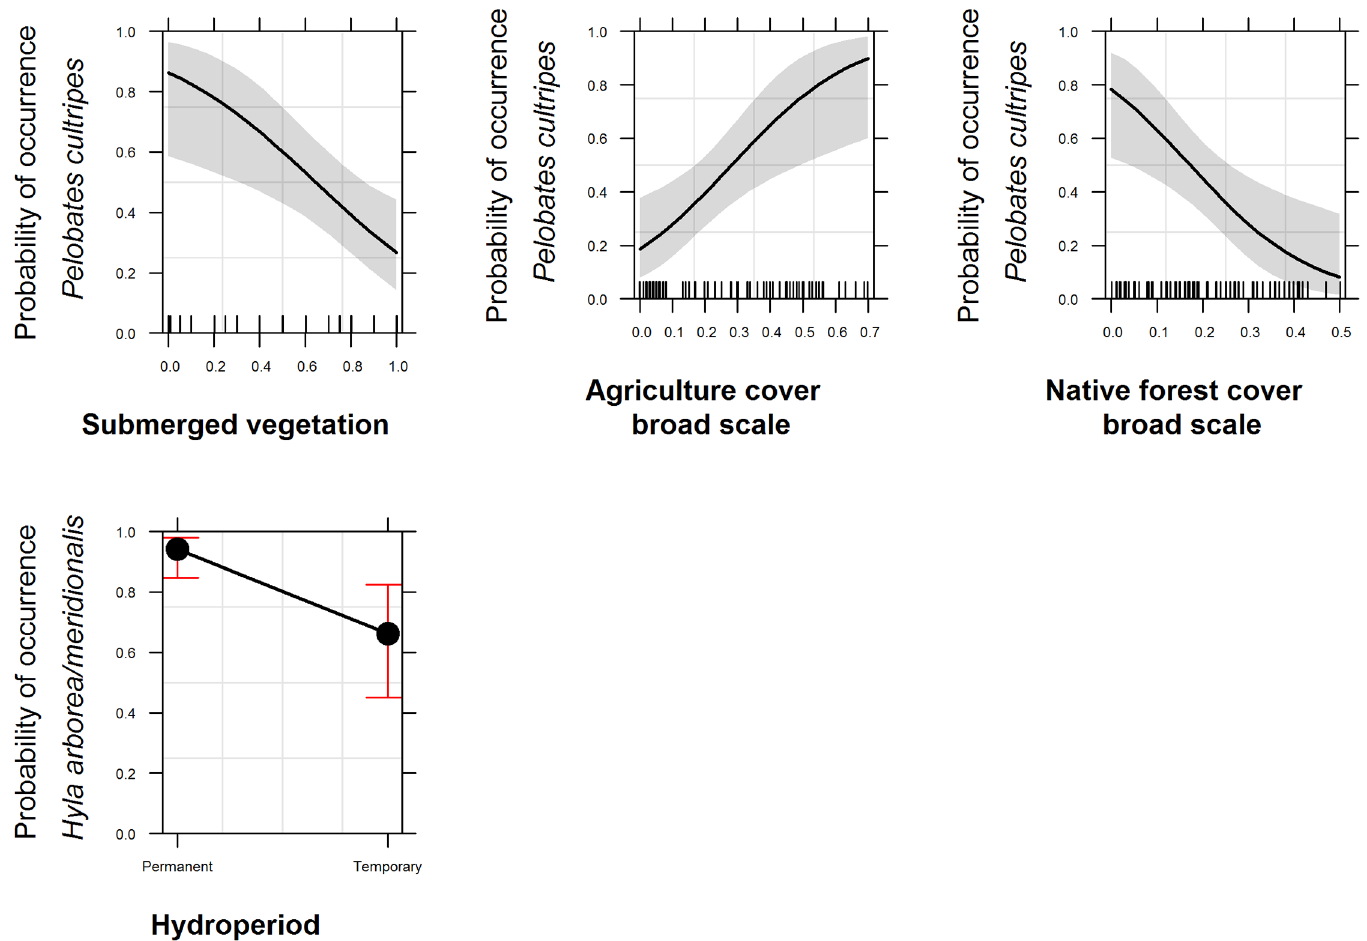
Fig 4. Fitted values predicted by the top ranked model for the anurans for each of the response variables with strong effect according to the odds ratio results. The dashed line are the confidence intervals at